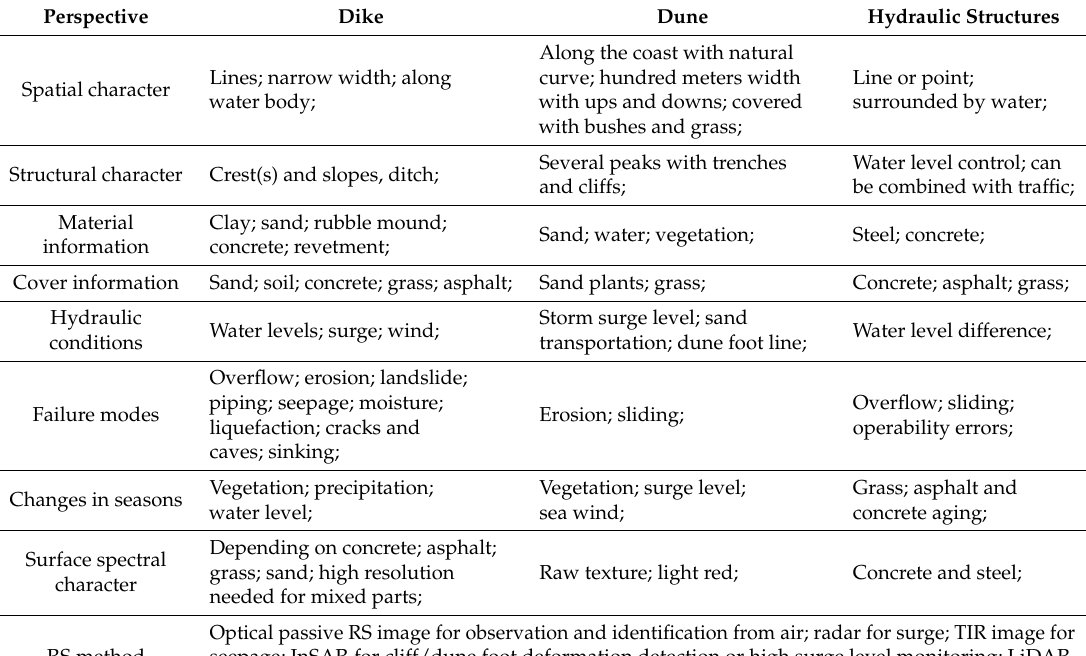
Table 2. Characteristics of the components in shoreline system from the point of view of RS